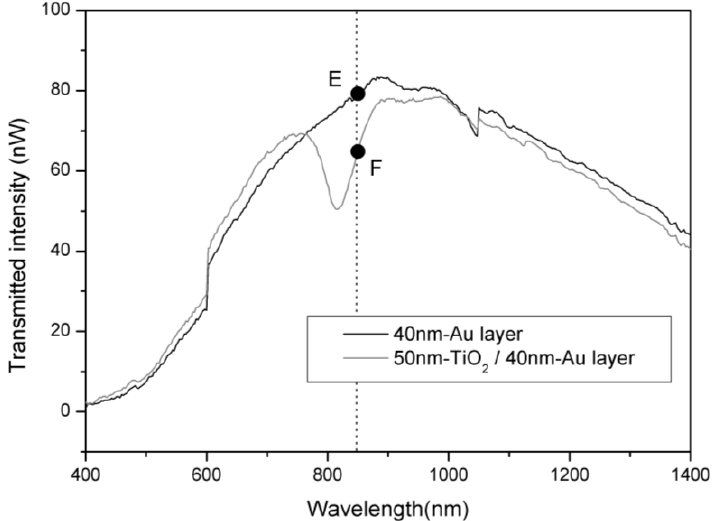
Figure 6. The spectroscopic SPR response with a halogen light source for a 50 nm layer of TiO deposited on an Au layer. The black and gray lines are the SPR spectra for a 40 nm-Au 2 layer and a 50 nm-TiO /40 nm-Au layer, respectively, as measured by OSA. The dashed 2 line is set to calculate the change of the intensity at 850